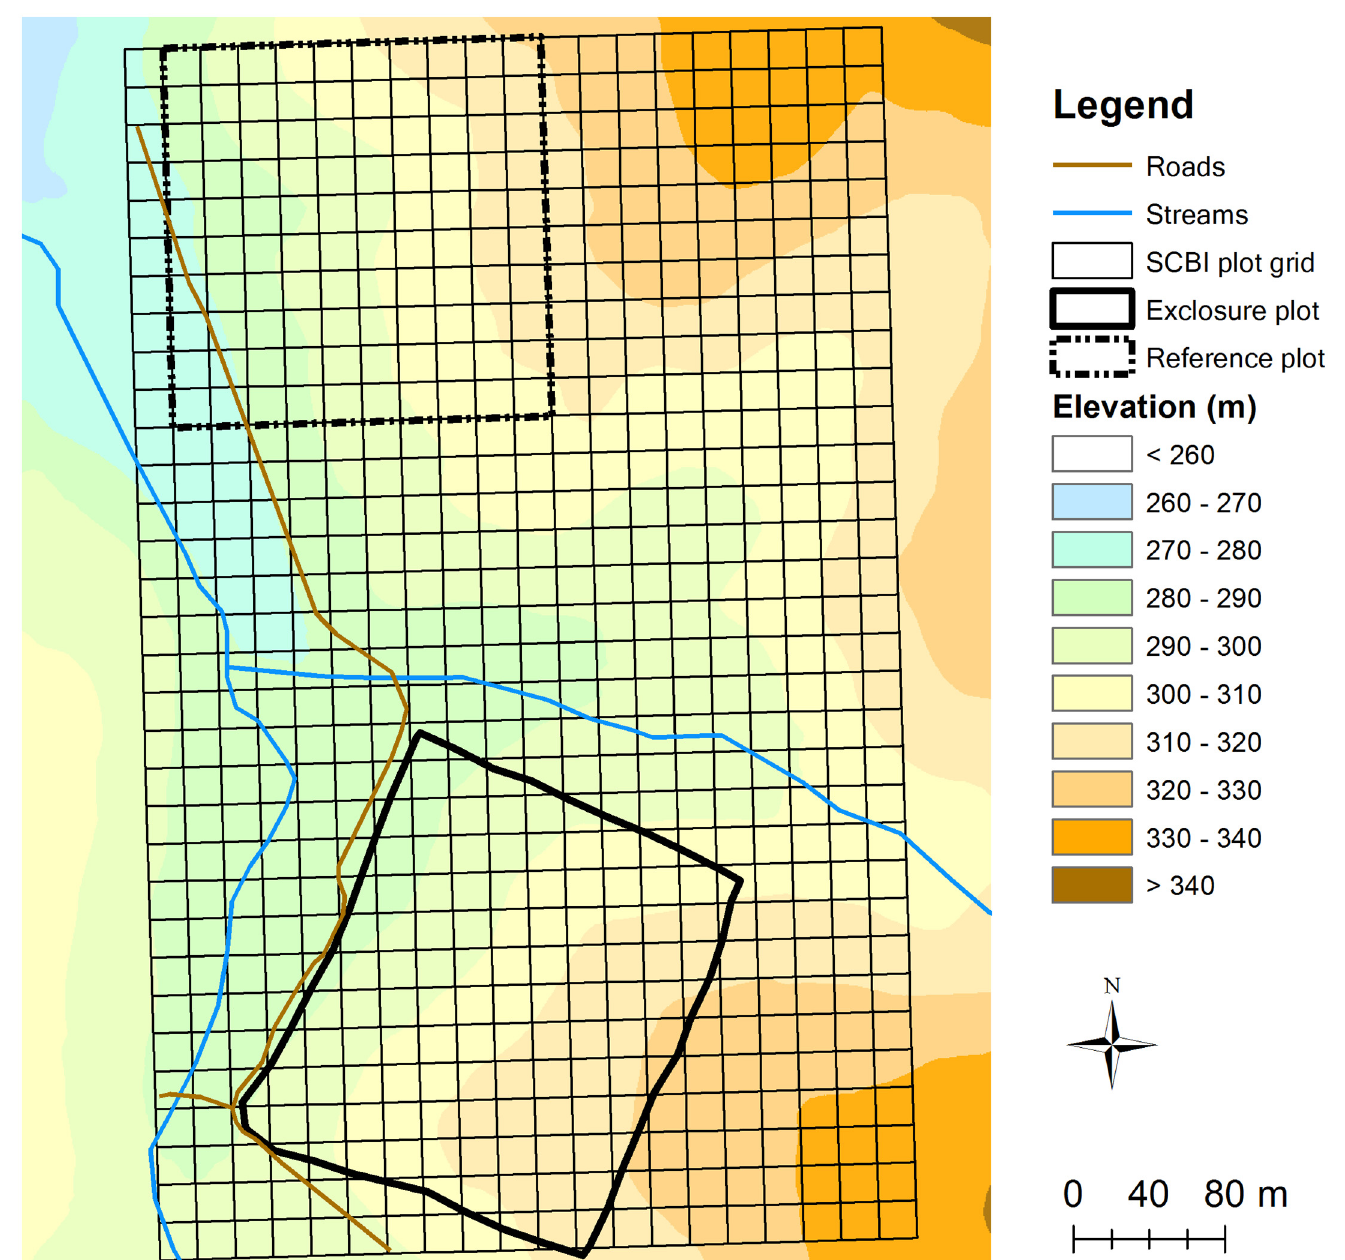
Fig 1. Map of the 25.6-ha (400 m x 640 m) SCBI forest plot as divided into 20 m x 20 m quadrats. The locations of the exclosure and reference plots are